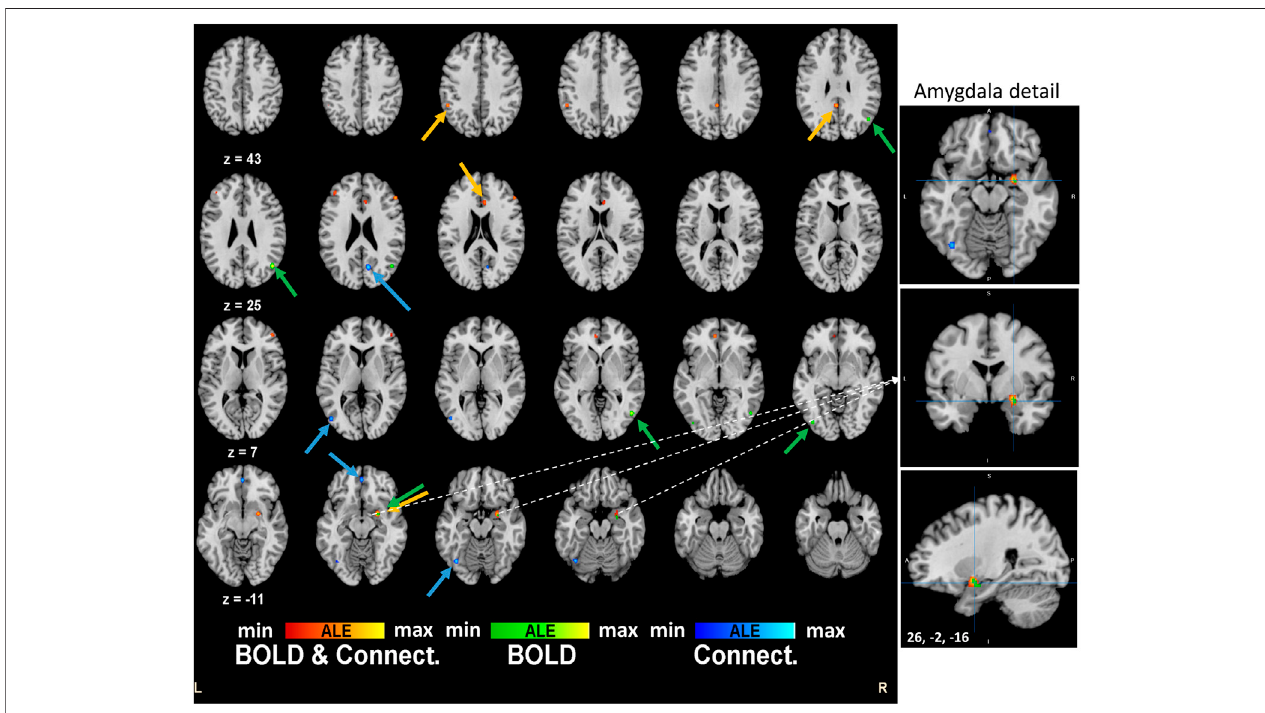
FIGURE 2 | Brain activation maps for tryptamine psychedelics studies. An extended network shows up in the quantitative meta-analysis. Frontal decision related areas and other visuo-temporal areas are affected by the drug. Particularly, right amygdala is implicated in the effects of the psychedelics drugs. These results are signi fi cant at p <